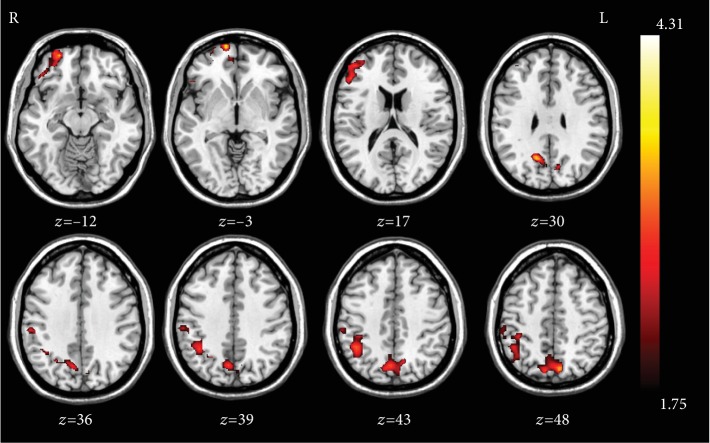
Comparison of the ALFF between rTMS treatment and SD. The neural activity-decreased brain regions (bilateral precuneus, right angular gyrus, and right middle prefrontal cortex) after SD showed a significant increase (red color) after rTMS treatment (p < 0.05, Alphasim-corrected).